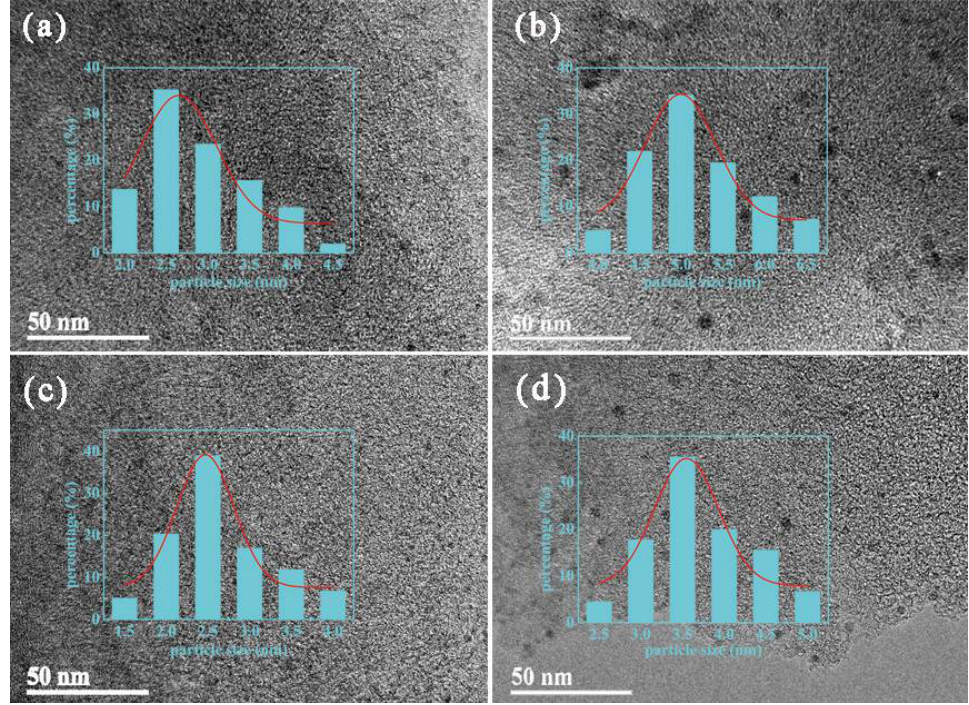
Figure 6. TEM images of fresh and used catalysts for Zn/AC ( a , b ) and Zn1Co0.3/AC ( c , d ).